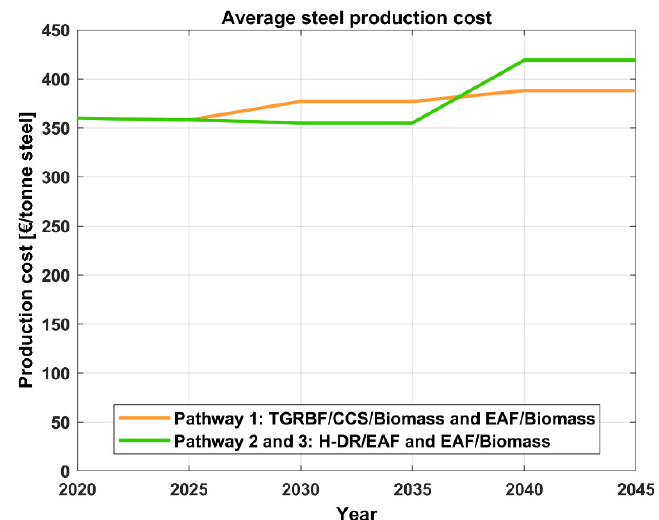
Figure 5. Development of the average steel production cost for the three pathways investigated.